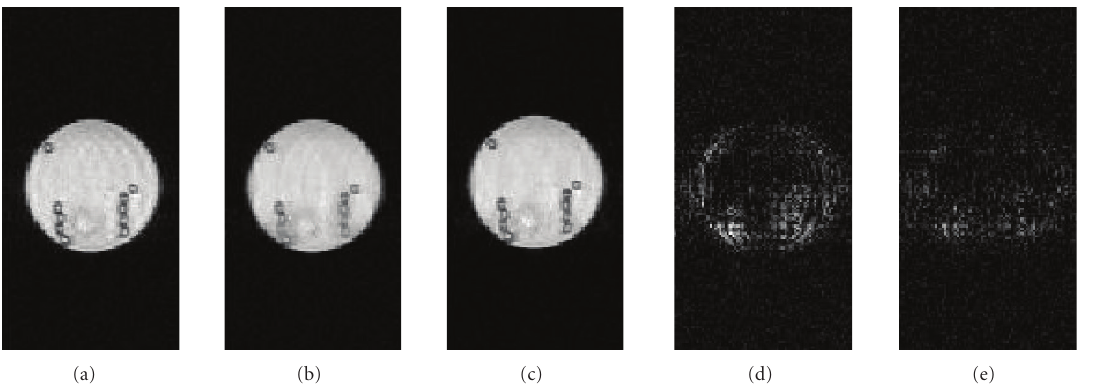
Figure 7: Results of multi-image reordering method on dynamic phantom data. Image at a time point reconstructed (a) from full k -space data using IFT, (b) from R ∼ 3 data using STCR without any reordering, and (c) from R ∼ 3 data using STCR with reordering in time and spatial dimensions. (d) Absolute di ff erence image between Figures 7(a) and 7(b). (e) Absolute di ff erence image between Figures 7(a) and 7(c).